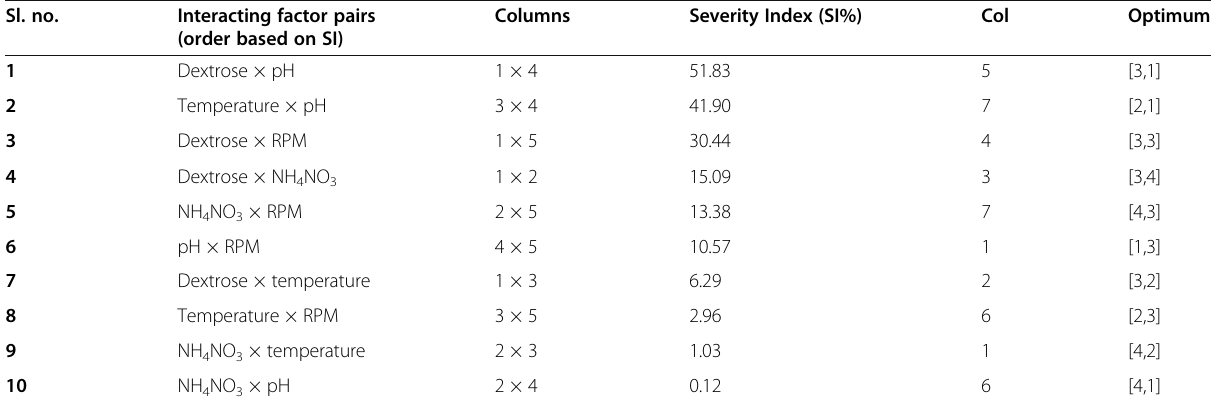
Table 3 The estimated interaction Severity Index of the factors under study Sl. no.